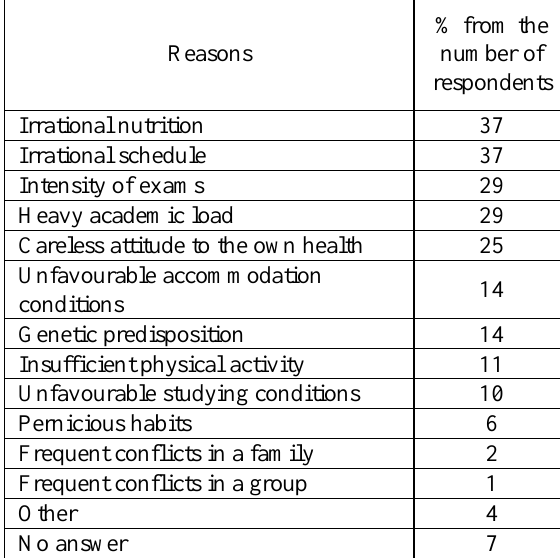
Table 3. Reasons for suffered diseases, 2012